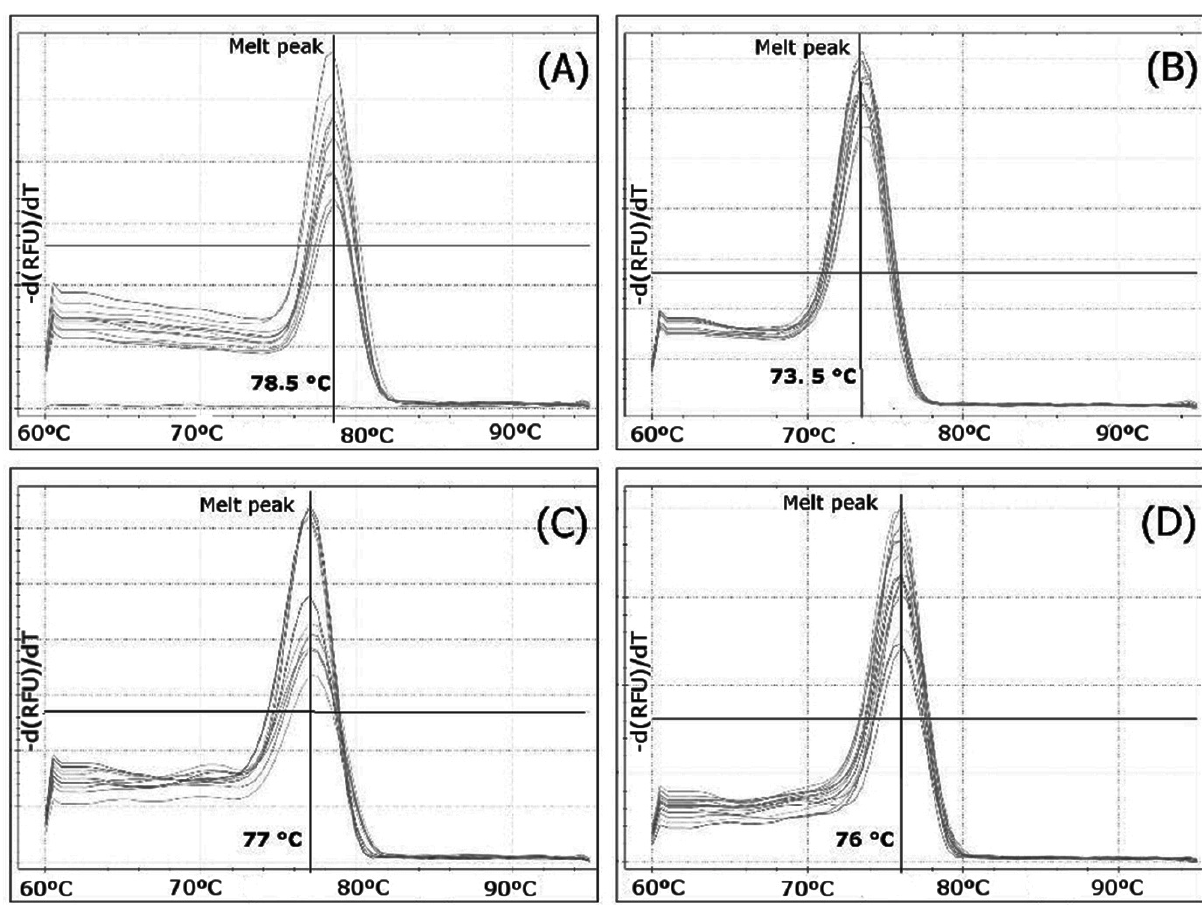
Figure 2. Melting curves using SYBR Green I for the detection of Apple mosaic virus , Apple stem grooving virus, Apple stem pit- ting virus and Apple chlorotic leaf spot virus fragments amplified with specific primers (Table 1), showing virus identification in infected apple trees. (A): ApMV; (B): ASGV; (C): ASPV and (D):